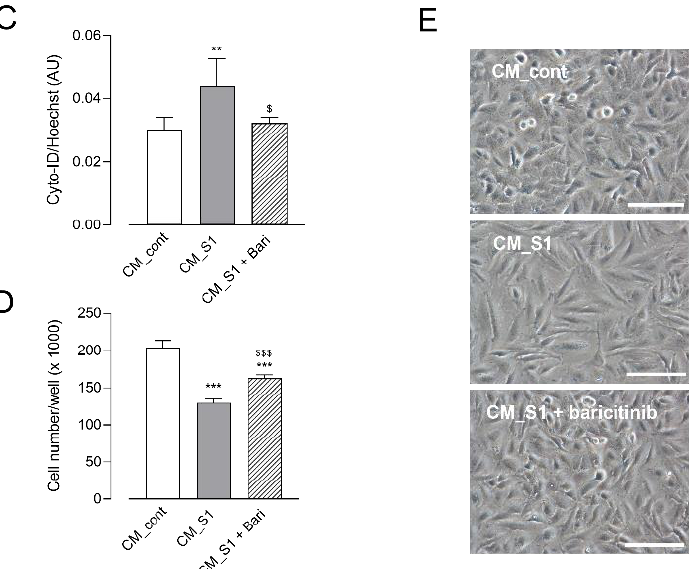
Figure 4. Effects of baricitinib on the cytostatic effects of conditioned medium from S1-treated macrophages in alveolar epithelial cells. A549 cells were maintained in RPMI or incubated in CM_cont or CM_S1 for the different times; where indicated, 1 µ M baricitinib was added to CM_S1, as detailed in Methods. ( A ) IRF-1 expression. The expression of IRF-1 mRNA (left) was measured by means of RT-qPCR and expressed as the fold change of cells maintained in RPMI (=1, dotted line). Bars are means ± SEM of four independent experiments (single dots), each performed in duplicate. *** p < 0.001 vs. CM_cont; $$$ p < 0.001 vs. CM_S1 with ANOVA. The expression of IRF-1 protein was assessed by means of western blot analysis (right), as detailed in Methods. A representative blot is shown that, repeated three times, gave comparable results. ( B ) Gene expression. The expression of the indicated genes was measured after 4 or 24 h of incubation by means of RT-qPCR, as described in Methods. The expression levels of each gene are expressed as the fold change of cells maintained in RPMI (=1, dotted line). Bars are means ± SEM of four independent experiments (single dots), each performed in duplicate. ** p < 0.01, *** p < 0.001 vs. CM_S1 with Student’s t -test. ( C ) Autophagy. After 72 h, autophagy was determined by employing CYTO-ID ® Autophagy Detection Kit, as described in Methods. Each bar represents the mean ± SD of five determinations within a representative experiment that, repeated three times, gave comparable results. ** p < 0.01 vs. CM_cont; $ p < 0.05 vs. CM_S1 with ANOVA. ( D ) Cell proliferation. Cells were counted after 48 h treatment, as described in Methods. Each bar represents the mean ± SD of five determinations within a representative experiment that, repeated three times, gave comparable results. *** p < 0.001 vs. CM_cont;